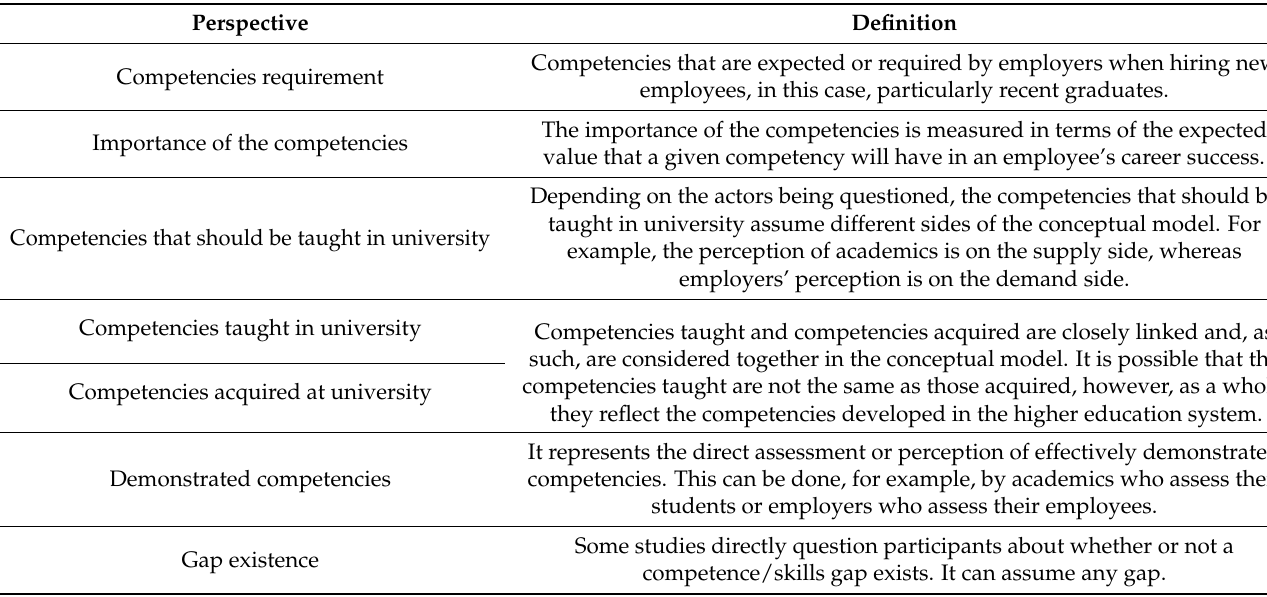
Table 4. Perspectives and their definition as found in the articles.